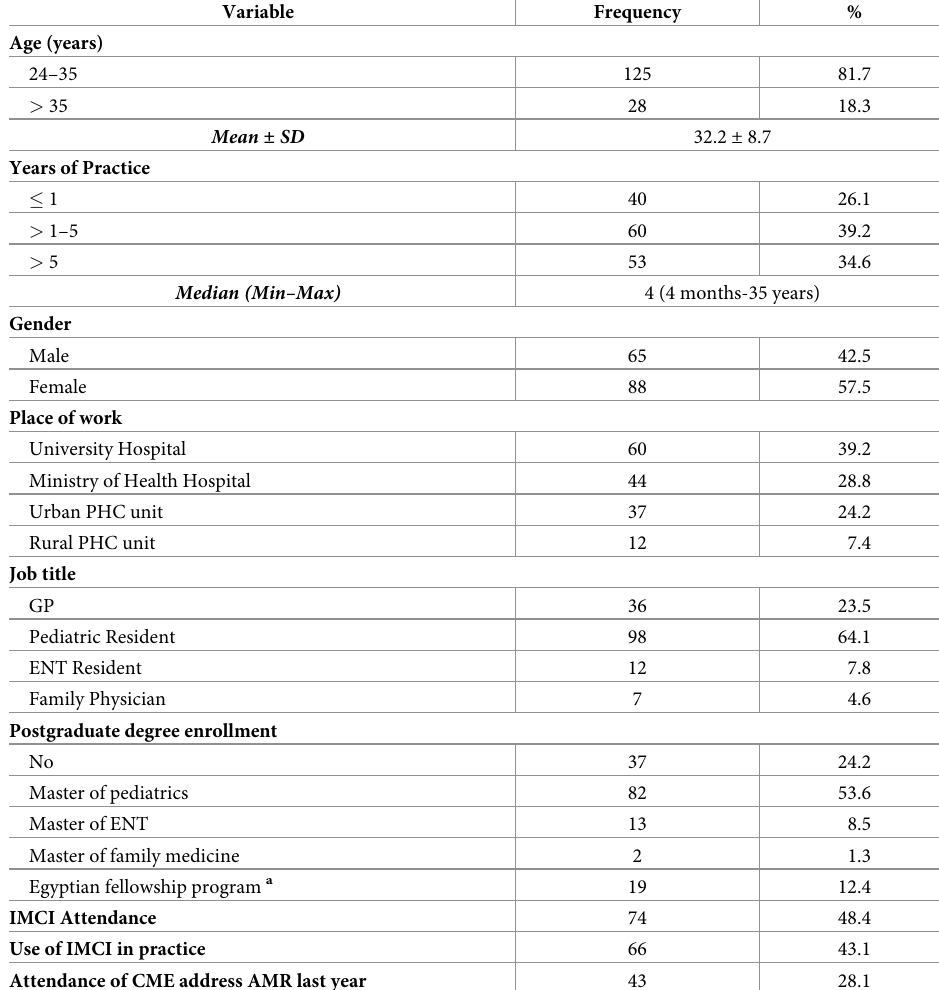
Table 2. Socio-demographic and professional characteristics of the study participants (n =